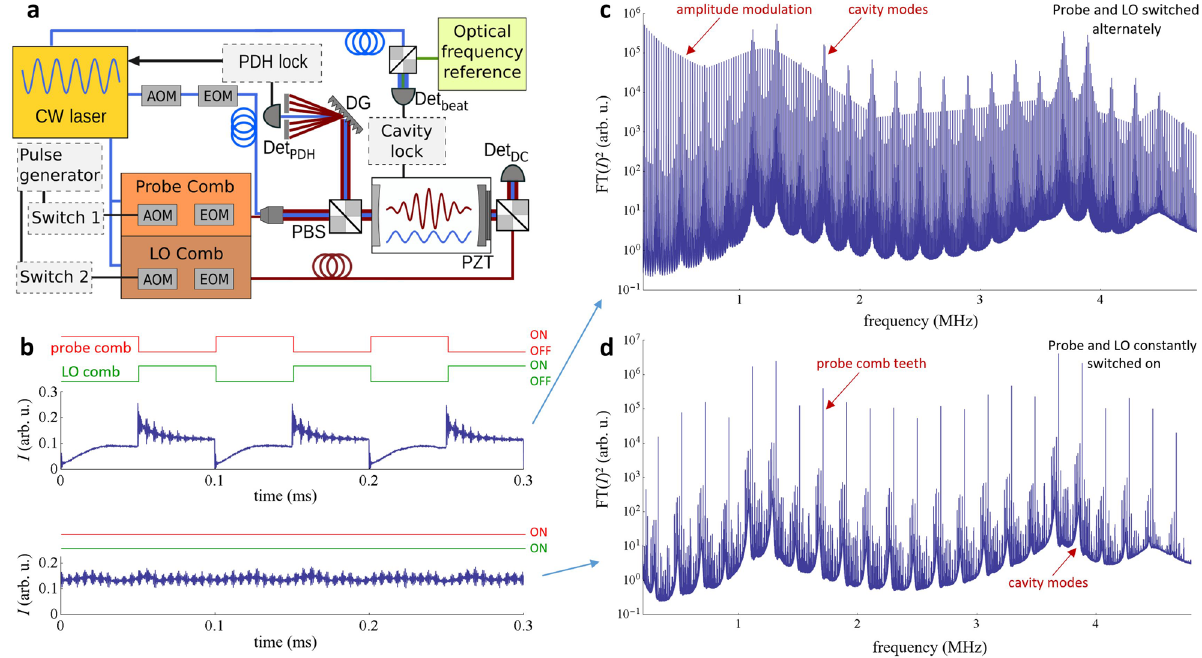
Figure 2. Experimental setup of a dual-comb cavity ring-down spectrometer. ( a ) Scheme of the experimental setup. Two frequency combs, probe and LO, are generated by a set of electro-optic modulators (EOM) from a single CW laser PDH-locked to the ring-down cavity. The diffraction grating (DG) spatially separates the CW-laser from the comb light. Frequencies of both combs can be shifted by the acousto-optic modulators (AOM) to match the probe comb teeth to the cavity modes and independently shift the LO comb offset. The ring-down cavity length is stabilized to the optical frequency reference (a femtosecond OFC). ( b ) Light intensity on the detector for two cases: switching both comb intensities (switches 1 and 2) with square waves of frequency f m = 10 kHz and opposite phases (red and green waveforms), or both probe and LO combs always on. Beating between the LO-comb and cavity transmission occurs only during the cavity ring-down phase of the modulation cycle in the former case (red trace low) and continuously in the latter case. ( c ) The magnitude squared of the Fourier spectrum of an output signal similar to the former case (upper panel in b ). The average of 200 spectra, each obtained from a 50-ms-long waveform (500 modulation periods) is shown. Coherently driven ring-down modulation results in a spectrum of cavity modes sampled discretely at multiples of the modulation frequency, f m . Additionally, a square-wave modulation spectrum is visible at odd multiples of f m . ( d ) The magnitude squared of the Fourier spectrum of an output signal similar to the latter case (lower panel in b ). Incoherently driven ring-down and buildup signals result in a pseudo-continuous sampling of the cavity mode transmission spectrum. The narrow steady-state transmission of probe comb teeth is also and long-term relative standard uncertainty below 2 × 10 −15 27 . The RF signals driving the AOMs and EOMs are synchronized to a common radiofrequency reference with a relative standard uncertainty of 3 × 10 −7 , which is a main component of the uncertainty of the optical frequency axis of measured spectra. For the highest frequencies of the probe comb teeth (± 11 GHz), the uncertainty of the frequency axis reaches 3.3 kHz. This uncertainty is lower than fundamental limit of CRDS spectral resolution given by the cavity mode widths. Representative heterodyne beat signal waveforms are shown in Fig. 2b, corresponding to either asynchro- nously alternating the probe and LO comb intensities (upper panel) or continuous comb operation (lower panel). These signals were acquired with the ring-down cavity filled with 19.6 kPa (147 Torr) of methane and mixed with 79.1 kPa (593 Torr) of nitrogen. Switching on and off the probe comb field with a square wave at a frequency f m leads to periodic intensity buildup and ring-down events at the cavity output. The LO comb can be switched on for the desired part of the waveform—ring-down, buildup or both to record the resulting beat signal at the output. The Fourier spectrum measured with the LO comb switched on during the ring-down phase is shown in Fig. 2c. A single waveform of duration equal to 50 ms corresponds to a spectral resolution of 20 Hz. With a modu- lation period of T m = f − 1 m = 100 µs for the probe comb and phase stabilization between f m and δ f r , the regularity